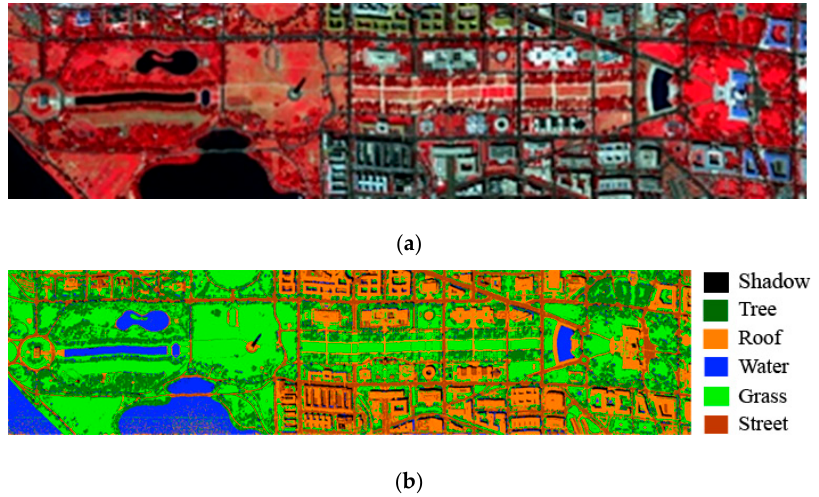
Figure 3. HYDICE WDM data: ( a ) false color RGB image RGB (50, 52, and 36); ( b ) ground truth image.